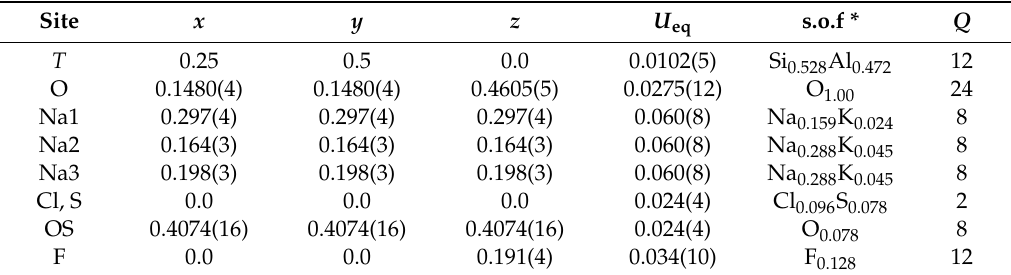
Table 5. Atom coordinates, equivalent displacement parameters (in Å 2 ), site occupancy factors (s.o.f.) and site multiplicities ( Q ) for the Sample 9.